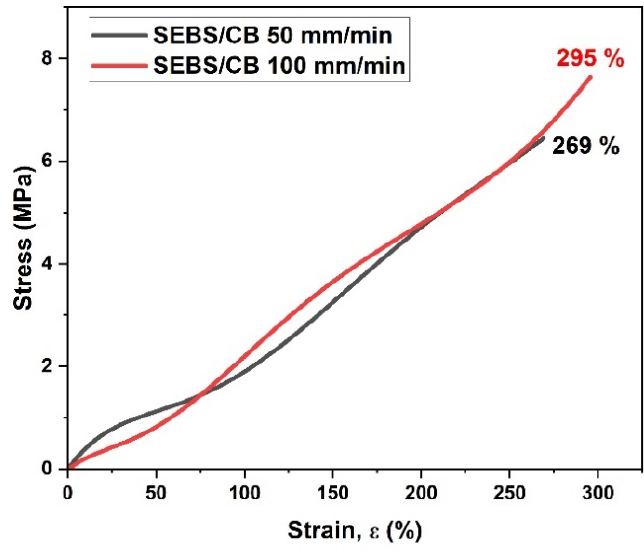
Figure 3. Stress–strain relation of the SEBS/CB 15% strand.